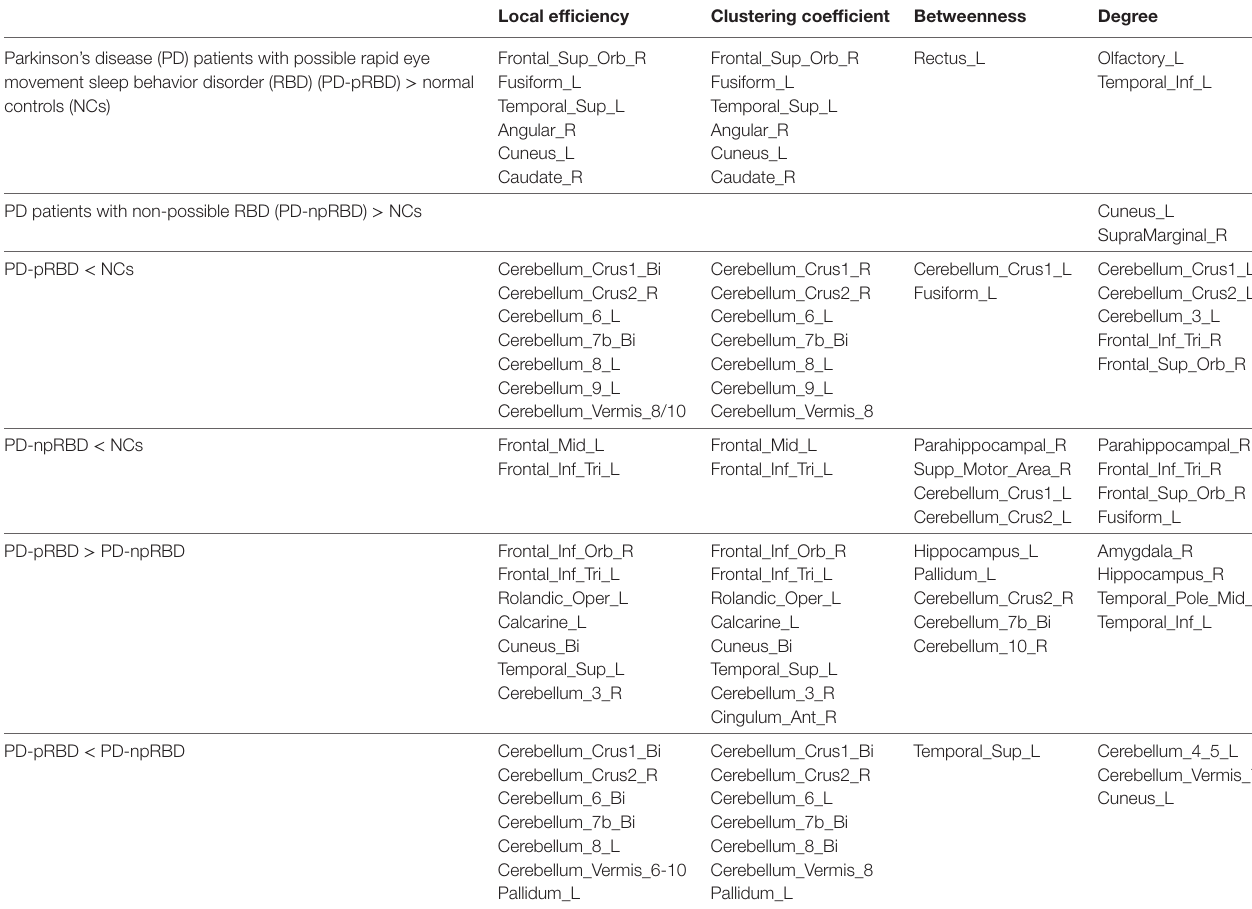
TaBle 3 | Comparisons of nodal measures between